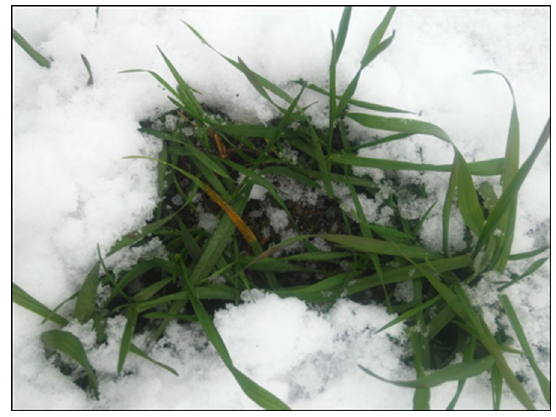
Fig. 6 Autumn-sown winter wheat seedling leaves showing developing stripe rust infection underneath snow patches in Baoji, western of Shaanxi Province in China, based on field observations on December 14,